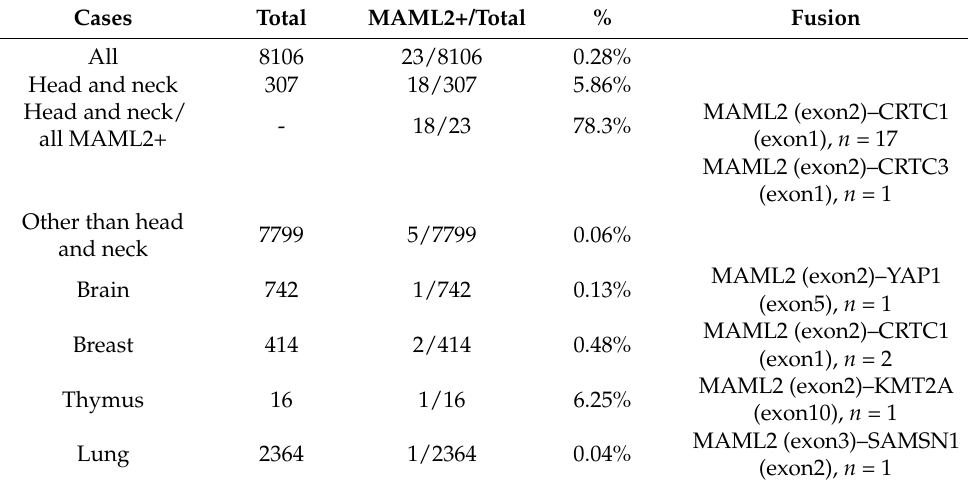
Table 1. MAML2 Fusion Frequency in Clinical